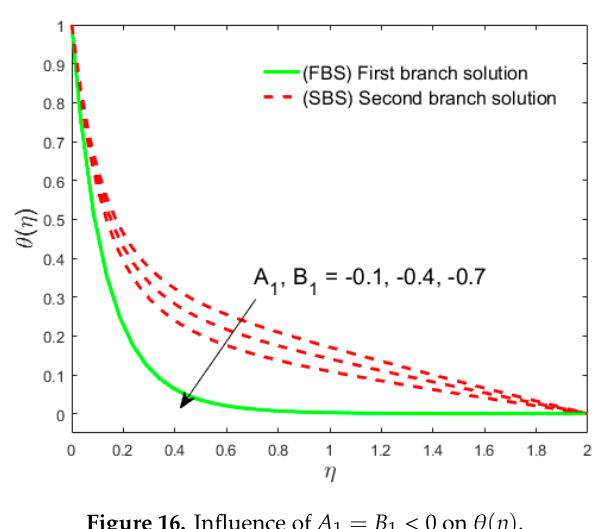
Figure 15. The impact of